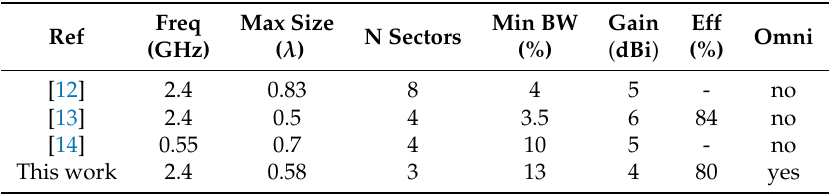
Table 3. Comparison with the